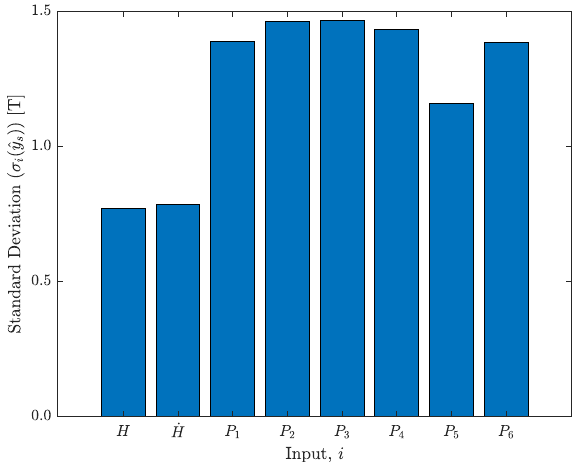
Figure 10. Sensitivity analysis results for each individual